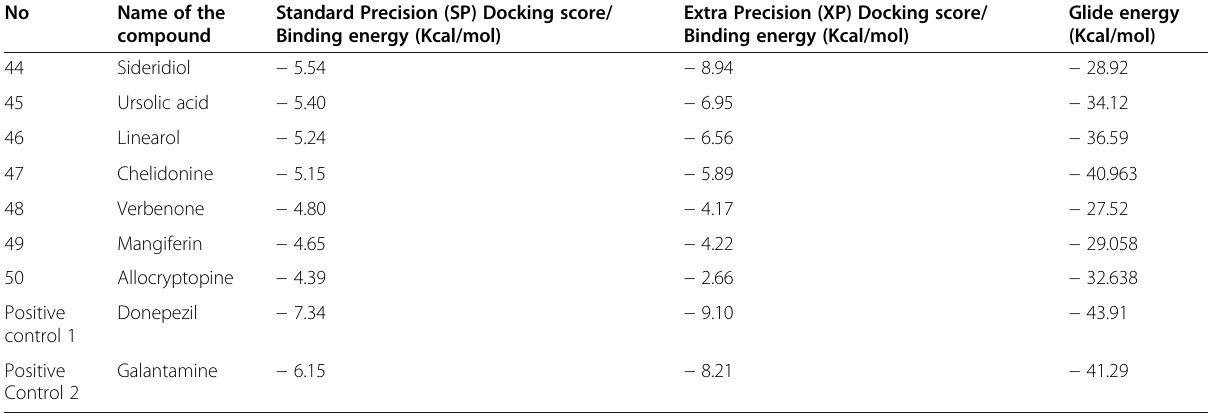
Table 3 The results of the SP and XP docking study of the selected ligands along with their respective glide energies (Continued)